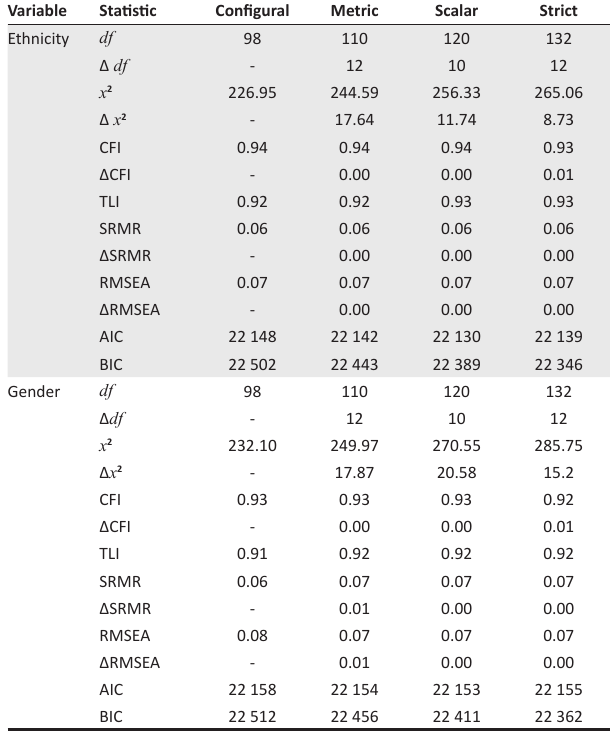
TABLE 6: Changes in fit statistics for an oblique lower-order model of passion with configural, metric, scalar and strict invariance across binary ethnic and gender